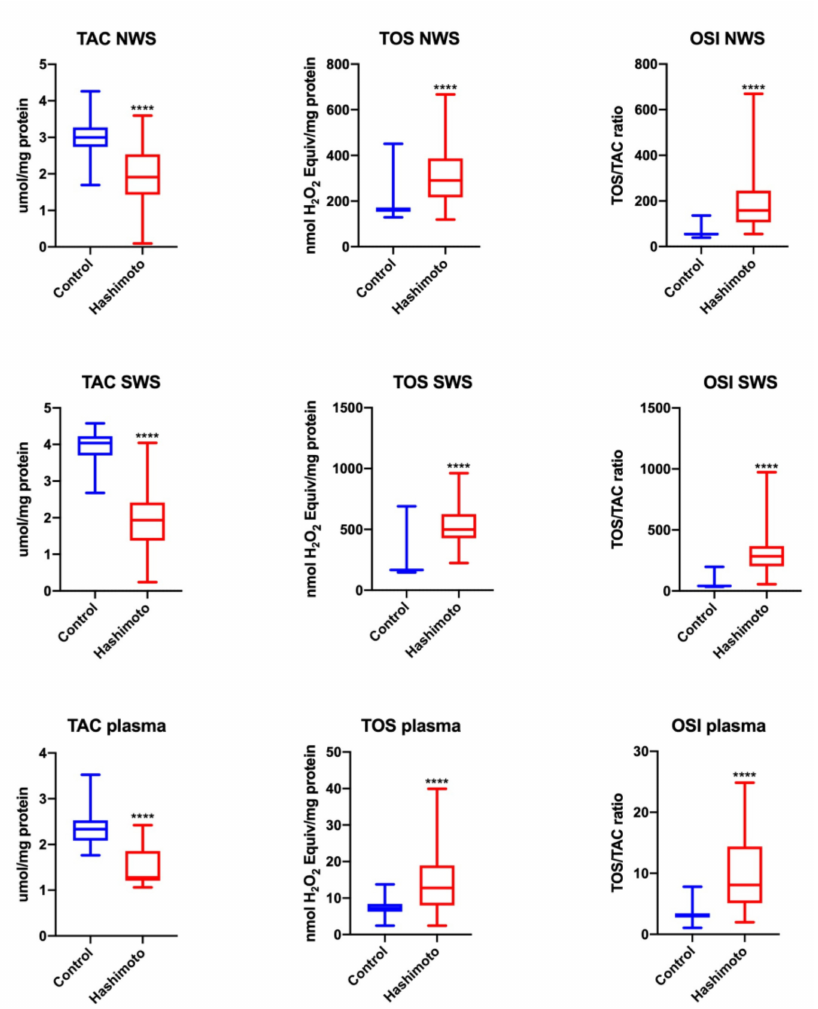
Figure 2. Redox status in NWS, SWS and plasma of the patients and control group. Data are shown as median (minimum–maximum). OSI—oxidative stress index; NWS—non-stimulated whole